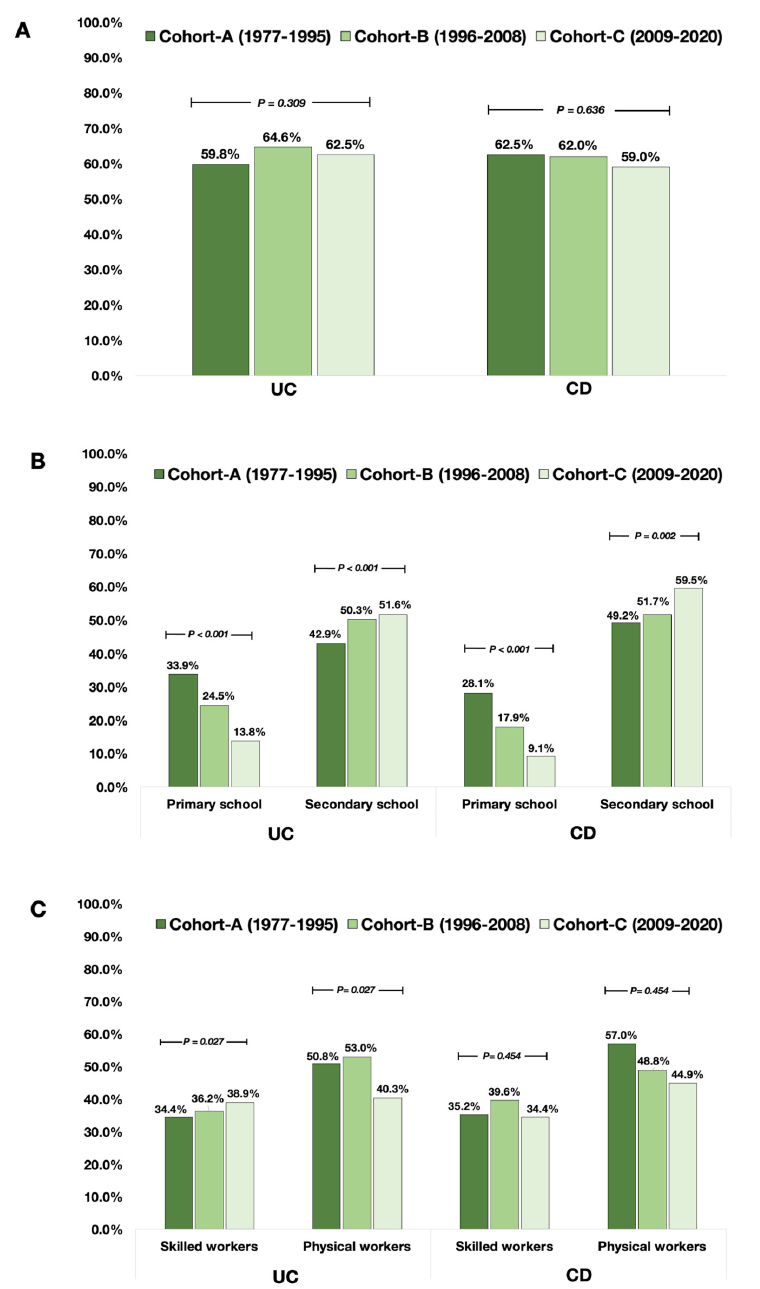
Figure 2. The trend of socioeconomic risk factors in the incident UC and CD patients. Note: ( A ) urban living area, ( B ) the highest education level (primary vs. secondary school or above) and ( C ) type of occupation (skilled vs. physical workers).